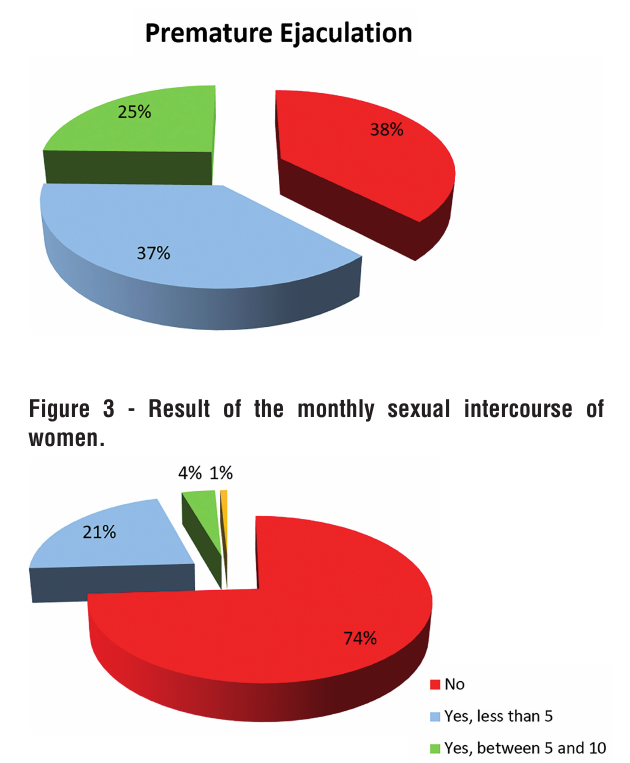
Figure 2 - Results of premature